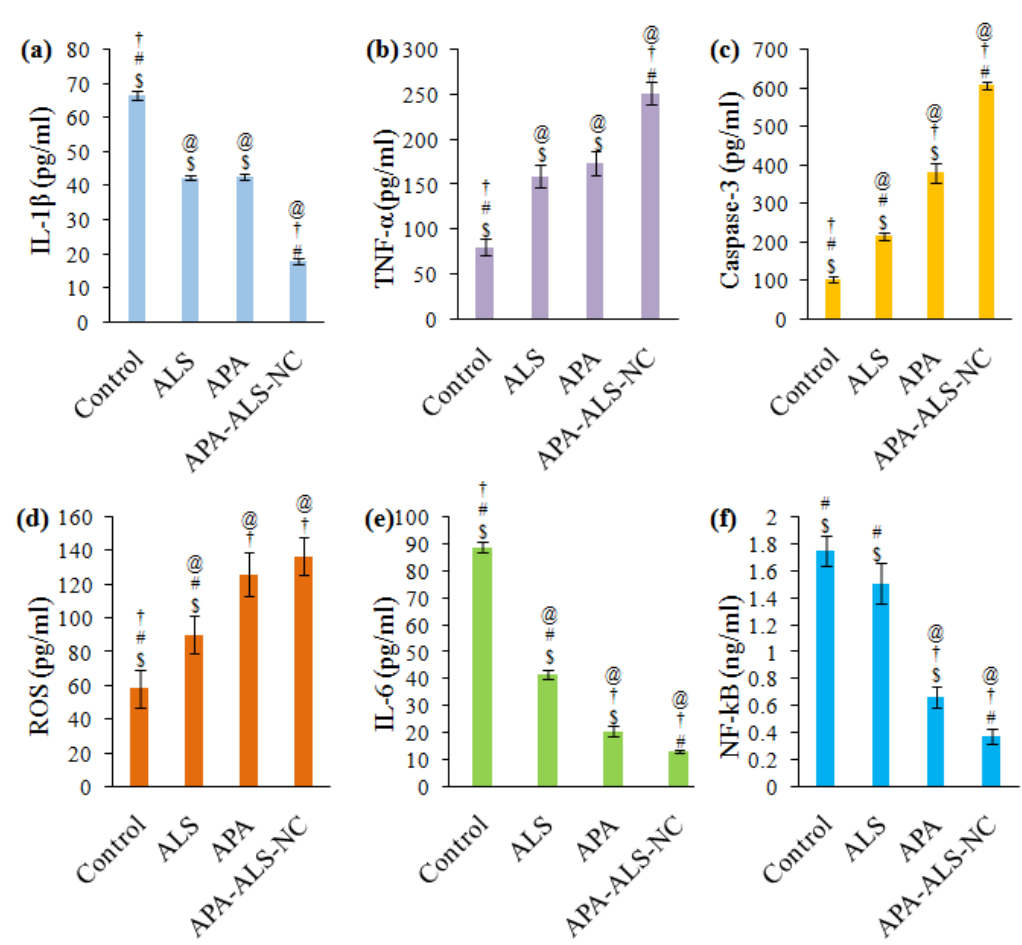
Figure 6. Effect of control, ALS, APA, and APA-ALS-NC samples on marker molecules ( a ) IL-1 β , ( b ) TNF- α , ( c ) caspase-3, ( d ) ROS, ( e ) IL-6, ( f ) NF-kB. (Statistical inferences: @ p < 0.05, in comparison to control; † p < 0.05, in comparison to ALS; # p < 0.05, in comparison to APA; $ p < 0.05, in comparison to APA-ALS-NC).